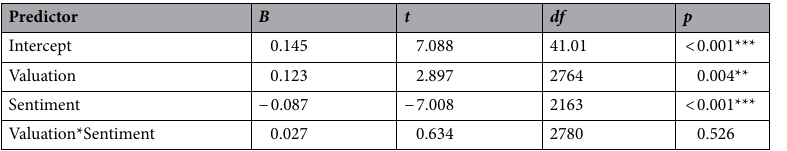
Table 2. Predicting participants’ congruent recommendation rating change from mean activity in valuation regions, sentiment of peer recommendations and their interaction (positive coefficients indicate greater change in the direction of the recommendation). * p < 0.05, ** p < 0.01, *** p <